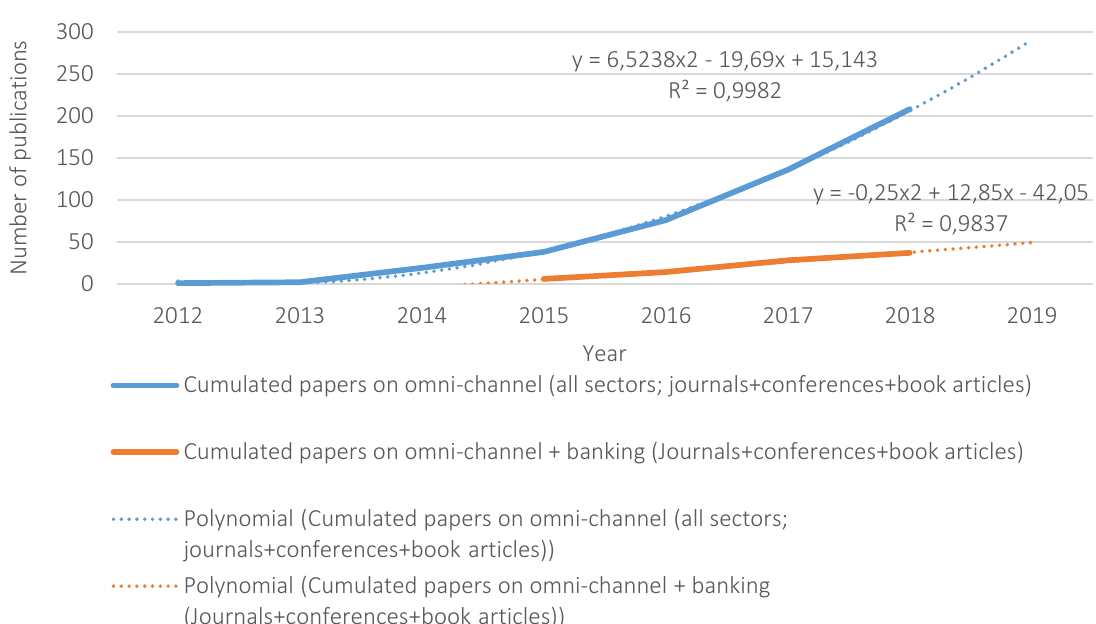
y = 6,5238x2 - 19,69x +